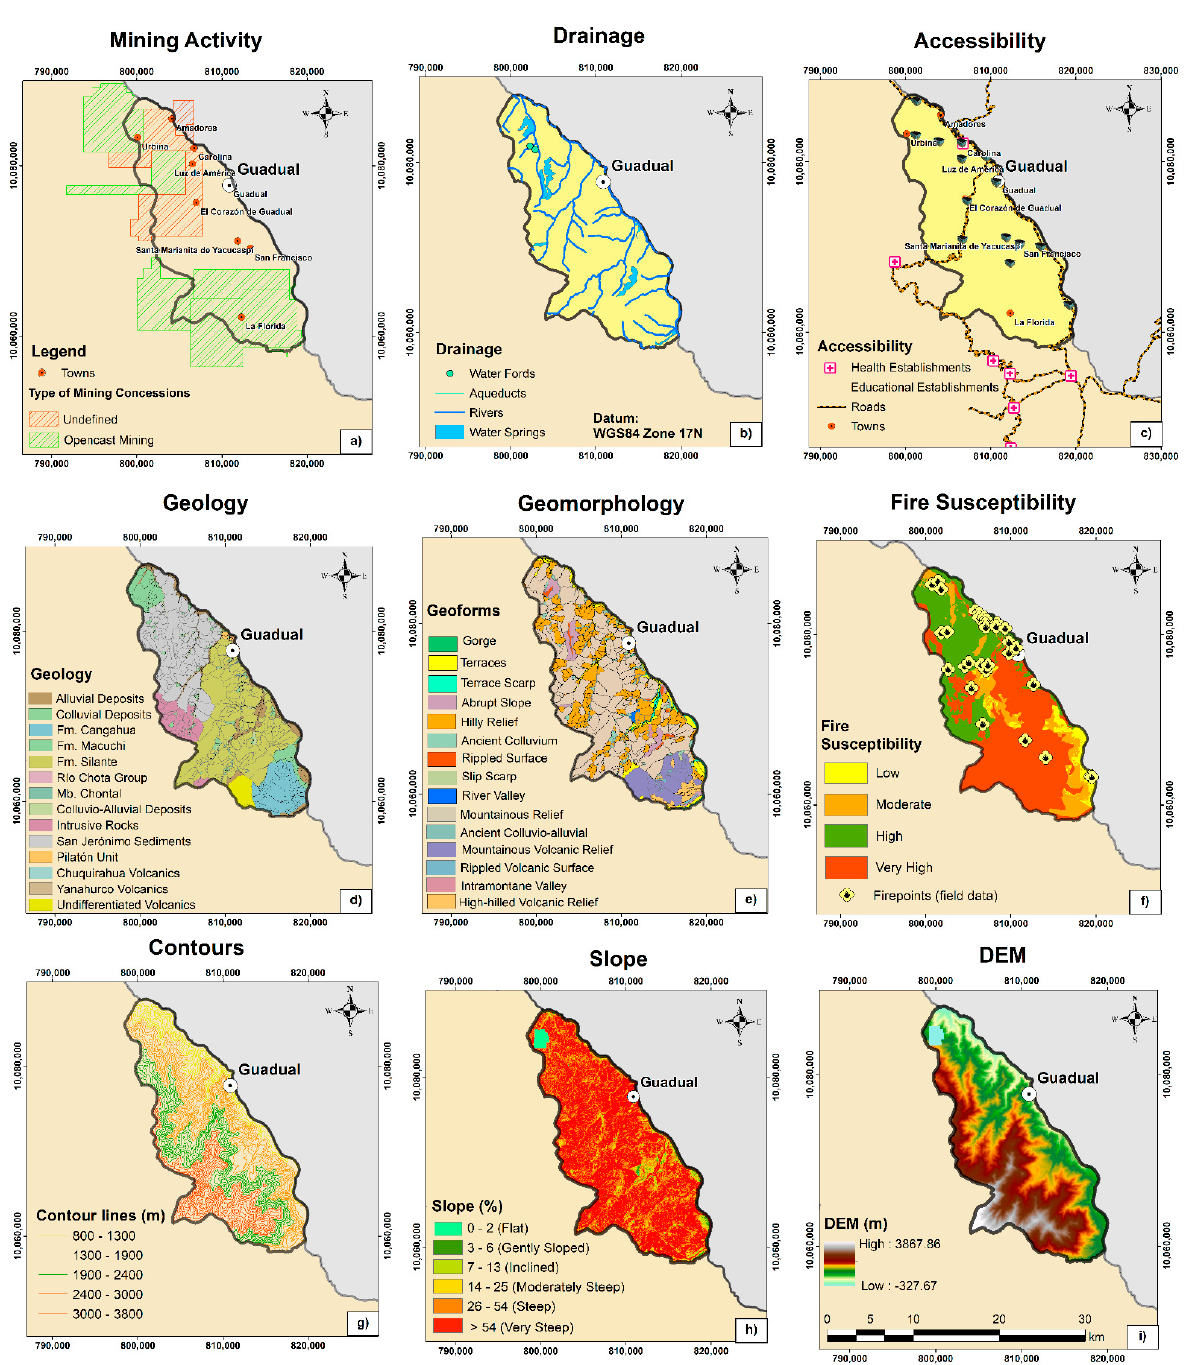
Figure 14. Main aspects considered for the proposal of the fire action plan. ( a ) Mining activity in the region, ( b ) drainage (water bodies), ( c ) accessibility (roads and health facilities), ( d ) geological formations, ( e ) representative geoforms, ( f ) fire susceptibility model and fire ‐ starting points, ( g ) contour lines (elevation), ( h ) slope classifications, ( i ) digital elevation model (DEM) or altitude map. Source: adapted from [74–77,125].